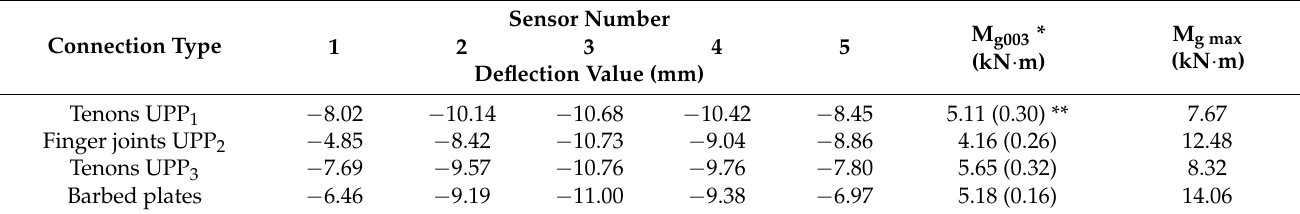
Table 6. Evaluation of the mechanical properties of manufactured models of lattice beams.